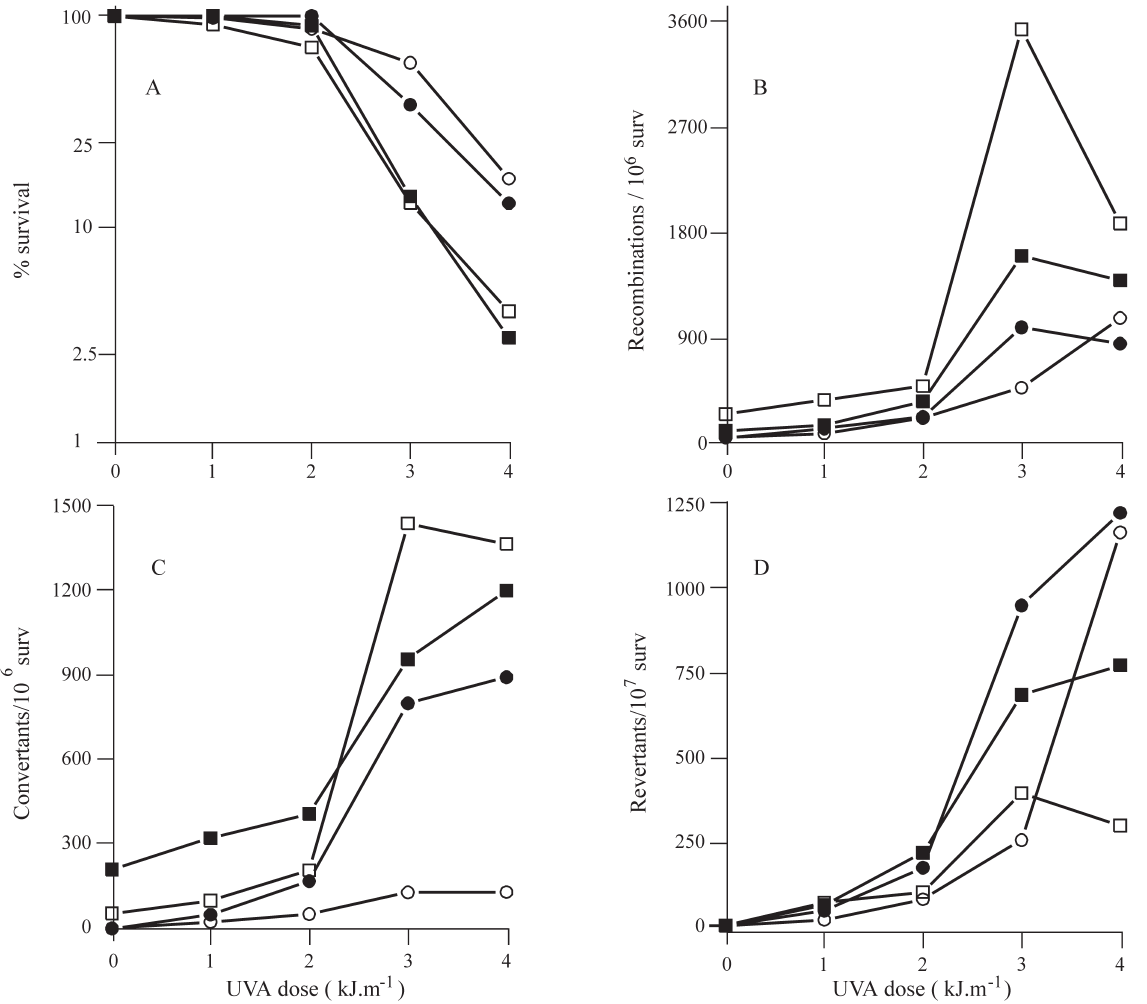
Figure 4 - Effect of recA gene expression on meiotic diploid yeast cells treated with 8-MOP+UVA. Figure A, percentage cell survival; Figure B, recipro- cal recombination; Figure C, gene conversion; Figure D, reverse mutation. Yeast transformants harboring control pNF2 plasmid ( (cid:1) ) or pNF2 recA plasmid ( (cid:1) ) were treated after one (closed symbols) or three (open symbols) days incubation in SPA